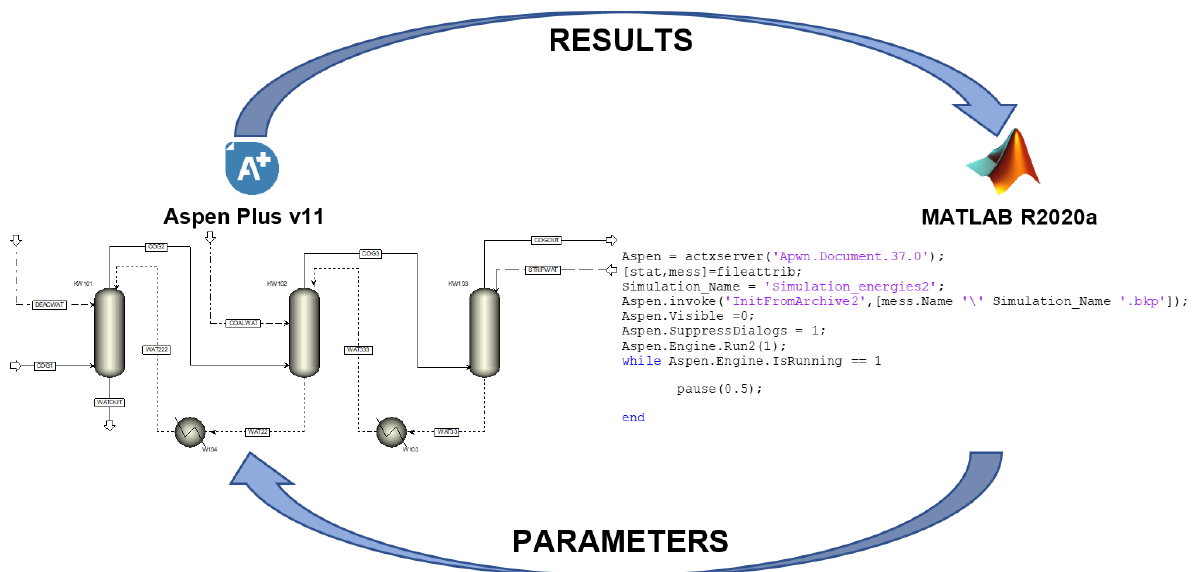
Figure 3. Aspen Plus and MATLAB